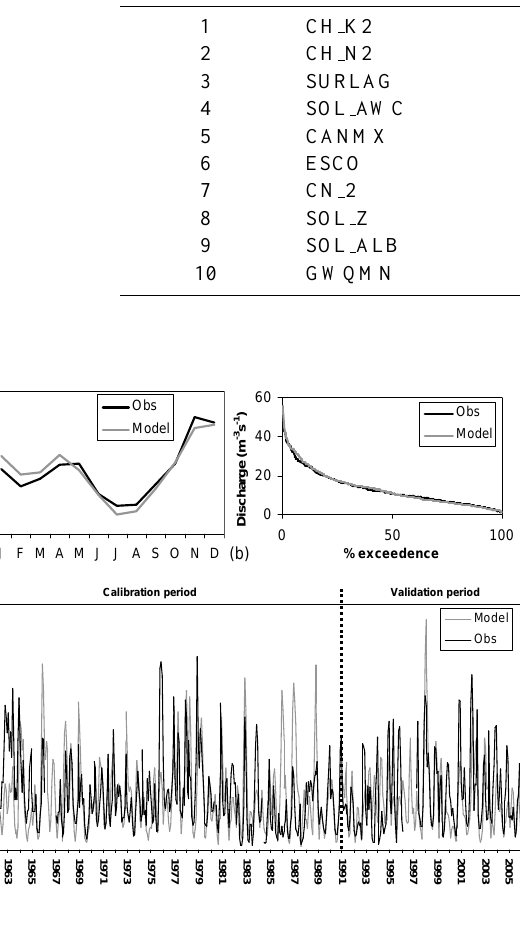
(a) monthly mean flow; (b) flow duration curve); and (c) 1961–